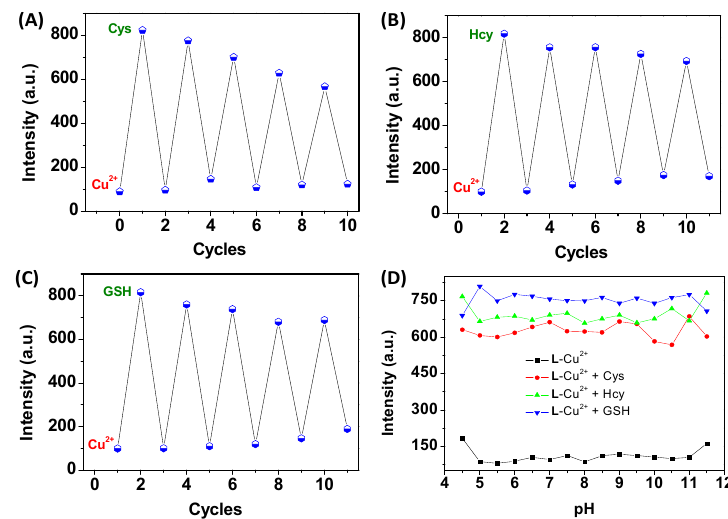
Figure 6. Fluorescence changes of L -Cu 2 + (10 µ M) at 443 nm in the DMF / HEPES mixed solution (7:3, v / v , pH = 7.4) upon the alternate addition of ( A ) Cu 2 + / Cys, ( B ) Cu 2 + / Hcy and ( C ) Cu 2 + / GSH with several concentration ratios. Cu 2 + / Cys: 0:0, 10:0, 10:10, 20:10, 20:20, 30:20; 30:30, 40:30, 40:40, 50:40. Cu 2 + / Hcy: 0:0, 10:0, 10:10, 20:10, 20:20, 30:20; 30:30, 40:30, 40:40, 50:40. Cu 2 + / GSH: 0:0, 10:0, 10:5, 20:5, 20:10, 30:10; 30:20, 40:20, 40:30, 50:30. ( D ) Influence of pH on the fluorescence intensities of L -Cu 2 + in the DMF / HEPES mixed solution (7:3, v / v , pH = 7.4) in the absence and presence of biothiols. The intensities were recorded at 443 nm, excitation was performed at 378 nm.